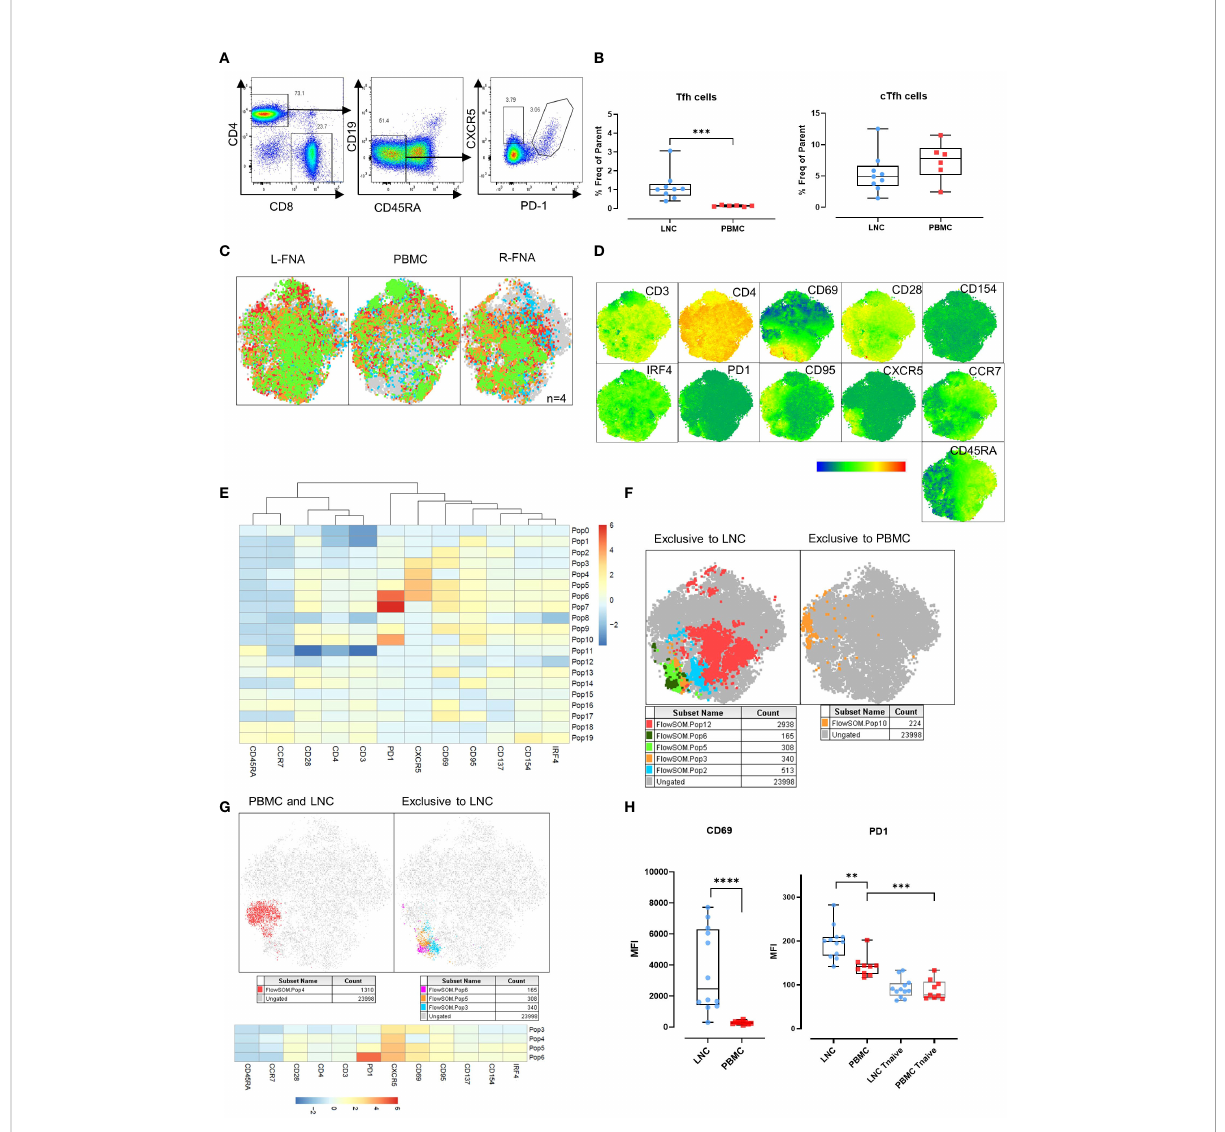
FIGURE 4 Germinal center (GC) Tfh in the lymph node, and circulating Tfh in blood and lymph node. (A) Representative gating strategy for T-follicular helper cells (Tfh) and circulating T-follicular helper cells (cTfh). Tfh were gated for live CD4+ T cells that were CD45RA-CD19- and expressing CXCR5 and PD-1. cTfh were gated for live CD4+ T cells expressing CXCR5 only. (B) Comparison of frequencies of Tfh (left panel) and cTfh (right panel) in CD4+ T cells in LNC and PBMC. Data are from n=6. The results of Mann-Whitney U tests are shown with *p<0.05, **p<0.01, ***p<0.001. (C) t-SNE from paired LNC and PBMC concatenated on live CD4+ T cells that were down sampled for 2063 events (CD4 T cells) from each participant (n=4). t-SNE was run with perplexity of 30. Data were gated to identify the samples for the left axilla fi ne needle aspirate (L-FNA), PBMC and the right axilla FNA (R-FNA), using SampleID (Figure S2). Color coding green, red, orange, and blue represents each of the different participants and grey dots represent the ungated cells that are absent in the subset. (D) Expression of immunophenotyping markers represented in heatmap statistical plots on tSNE generated by concatenating paired LNC and PBMC on live CD4+ T cells that were down sampled for 2063 events (CD4 T cells) from each participant (n=4), with the legend showing the scale of expression from low (in blue), to high (in red). (E) Population heatmap statistics for the twenty FlowSOM populations generated on tSNE of paired LNC and PBMC concatenated on live CD4+ T cells that were down sampled for 2063 events (CD4+ T cells) from each participant (n=4), showing the expression of the immunophenotyping and activation markers. (F) FlowSOM with 20 meta clusters applied on the concatenated CD4+ T cell data. From 20 different meta clusters, subpopulations exclusively occurring in LNC or PBMC were identi fi ed manually and are shown in the legend below each tSNE plot. (G) FlowSOM population overlay on t-SNE analysis of CXCR5+ CD4+ T cells found in PBMC and LNC (left panel) and in LNC exclusively (right panel). Subpopulations exclusively occurring in LNC or PBMC were identi fi ed manually and are shown in the legend below each tSNE plot (H) Comparison of the median fl uorescence intensity (MFI) of CD69 and PD1 expression on CD4+ CXCR5+ CD45RA- T cells and CD45RA+CCR7+ naïve T cells expressing PD-1 in LNC and PBMC. Results show analysis by Mann-Whitney U tests **p<0.01, ***p<0.001,